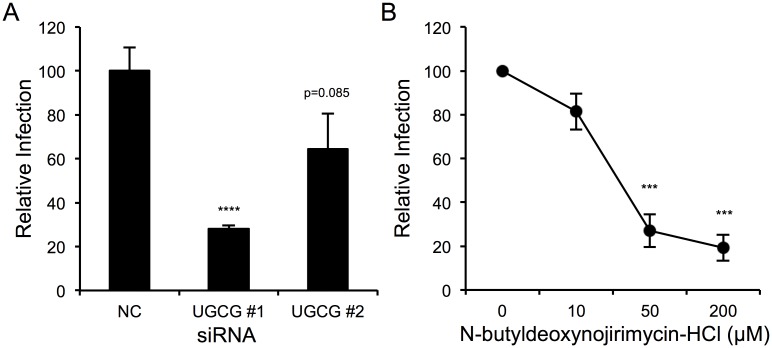
UGCG activity and expression important for wild-type SFTSV infection.(A) U-2 OS cells were transfected with siRNAs to UGCG or a non-targeting control and 72 hours later were infected with SFTSV (strain HB29, MOI 0.1). Supernatants from infected cells were collected 48 hours post-infection and viral output was determined by plaque assay. Infectious output is expressed relative to the negative control siRNA. (B) U-2 OS cells were pre-treated with NB-DNJ for 48 hours before infection with SFTSV (MOI 5). Supernatants from infected cells were collected 12 hours post-infection and viral output was determined by plaque assay. Infectious output is expressed relative to the untreated control. *** p<0.001, **** p<0.0001 using Student’s t-test with Bonferroni correction.